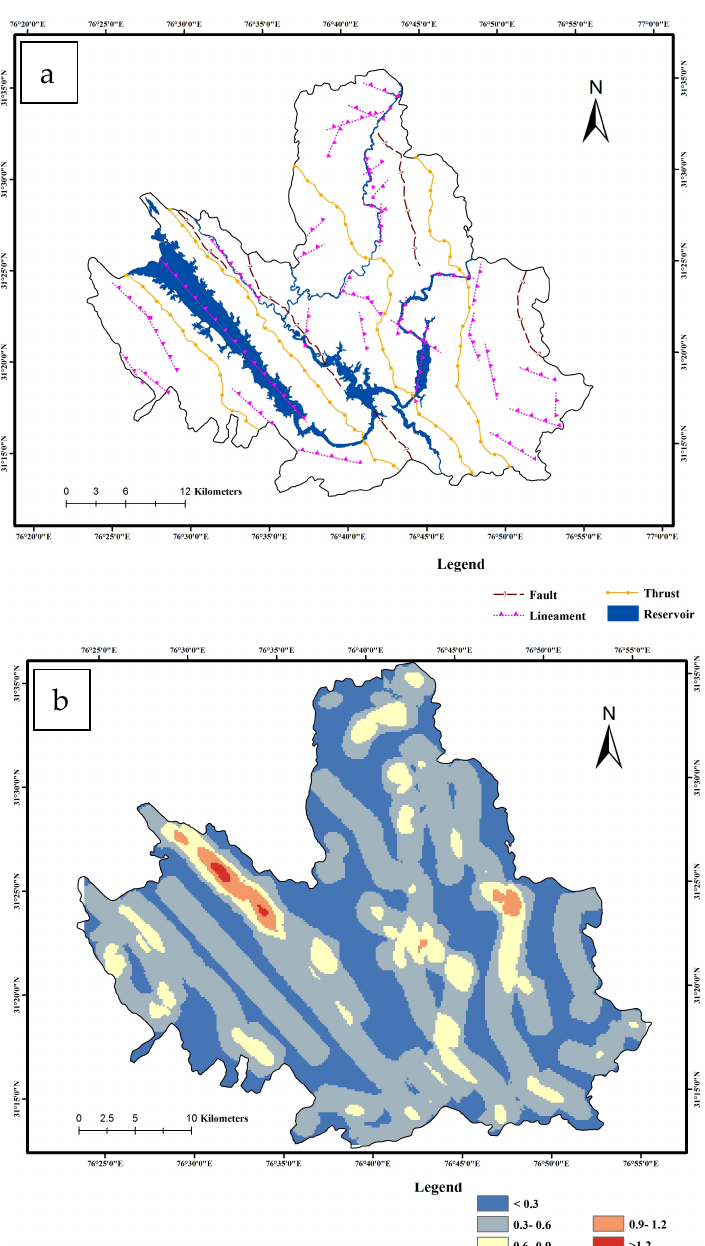
Figure 5. ( a ) Structure map of Bilaspur district; ( b ) Lineament density map of Bilaspur district.